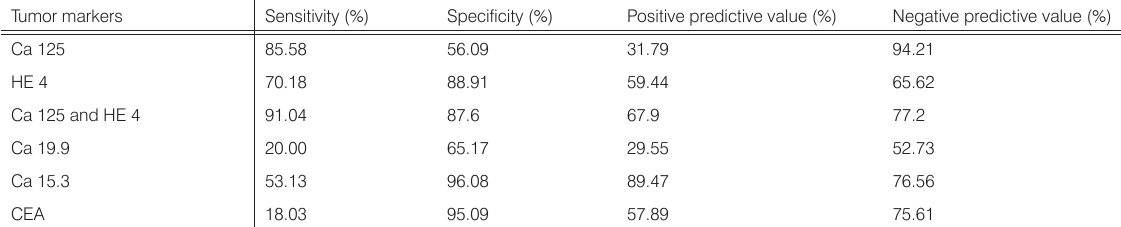
Table 2. Sensitivity, specificity positive and negative predictive values of examined tumor